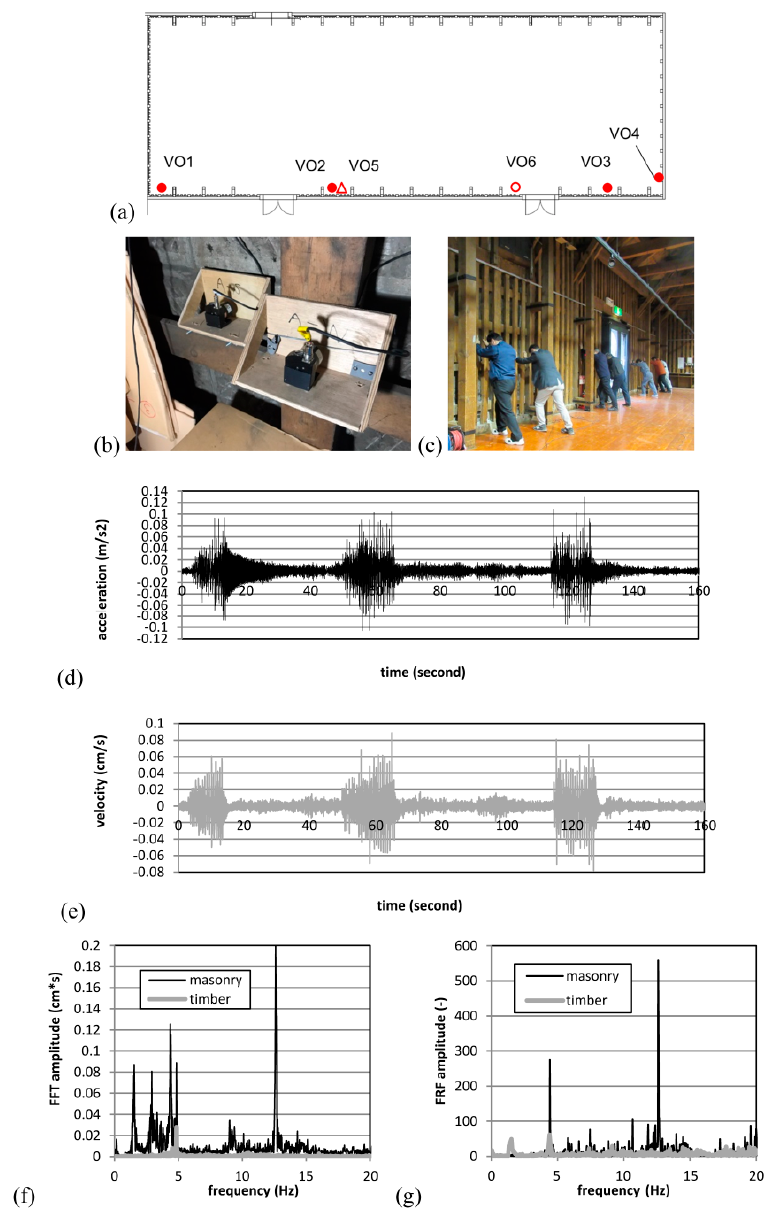
Figure 5. Vibration testing of the Otaru warehouse: ( a ) location of the velocity meters, ( b ) installation of velocity meters to a stud and wall, ( c ) manual excitation during forced vibration tests, the acceleration time history of VO2 sensor ( d ) and of VO5 sensor ( e , f ) Fourier spectrum of sensors and ( g ) wall/stud to floor frequency response functions.